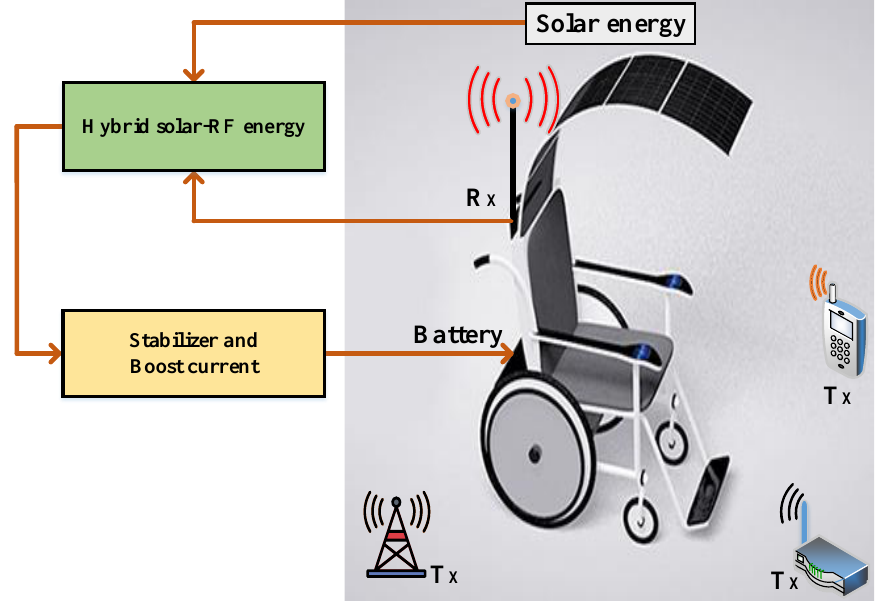
Figure 1. The block diagram of model system for brain operated